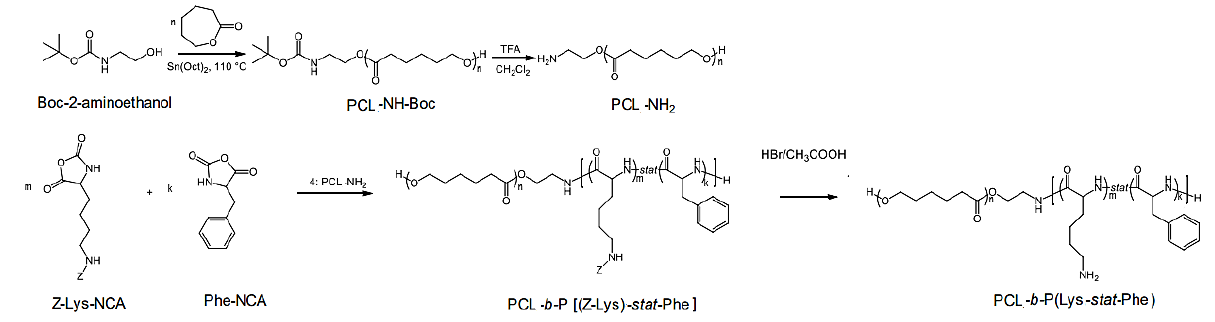
Figure 11. Synthetic route to obtaining block copolymers poly(ε-caprolactone)-block-poly(Lys-co-Phe) based on [321].